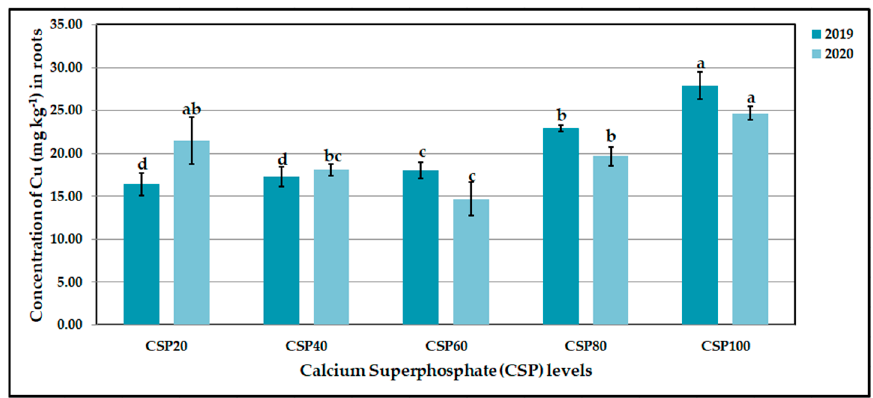
Figure 12. Influence of calcium superphosphate (CSP) levels on root copper (Cu, mg kg − 1 ) contents of CaCO 3 ‐ stressed sweet potato plants in 2019 and 2020 seasons. Bars with a different letter indicate significant difference between treatments at p ≤ 0 .05. CSP 20 , CSP 40 , CSP 60 , CSP 80 , and CSP 100 represent CSP added as a soil application at 69, 138, 207, 276, and 345 kg ha − 1 , respectively.